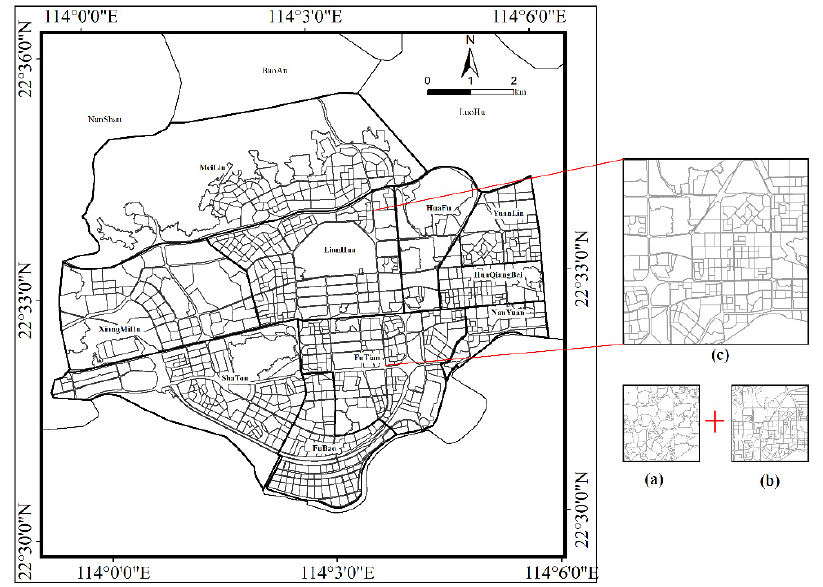
Figure 2. Spatial unit for identifying the urban functional areas: ( a ) feature boundaries; ( b ) road network; ( c ) spatial unit.